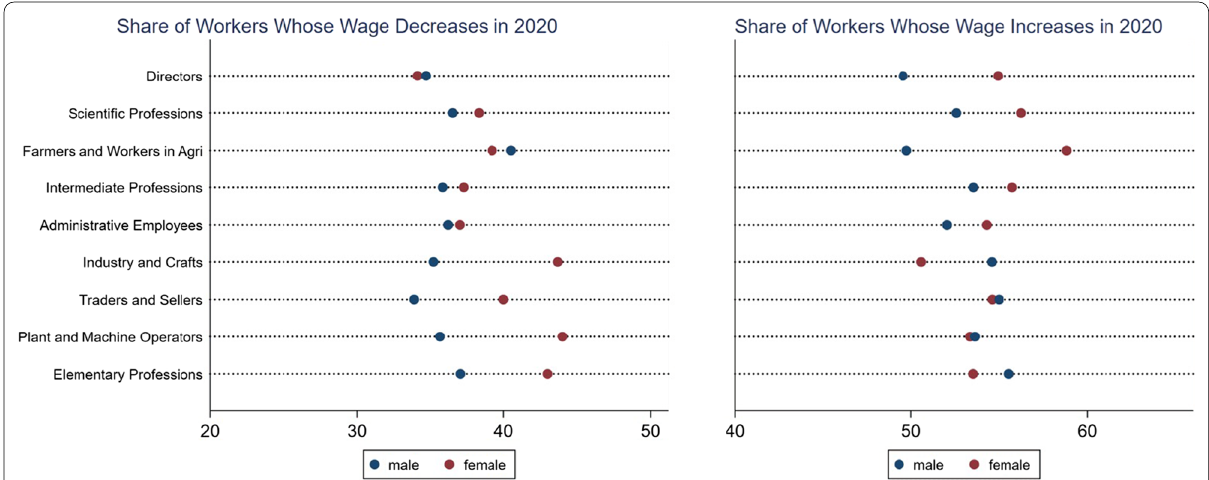
Fig. 10 Wage changes by gender and occupation. Notes We restrict the sample to respondents with wage information (annual income/occupation rate, unit: CHF per percentage occupation rate) in 2019 and 2020, calculate the percentage of respondents whose wage has decreased/increased from 2019 to 2020, and then break it down by occupation types and gender. Occupations are ranked in descending order of telework availability